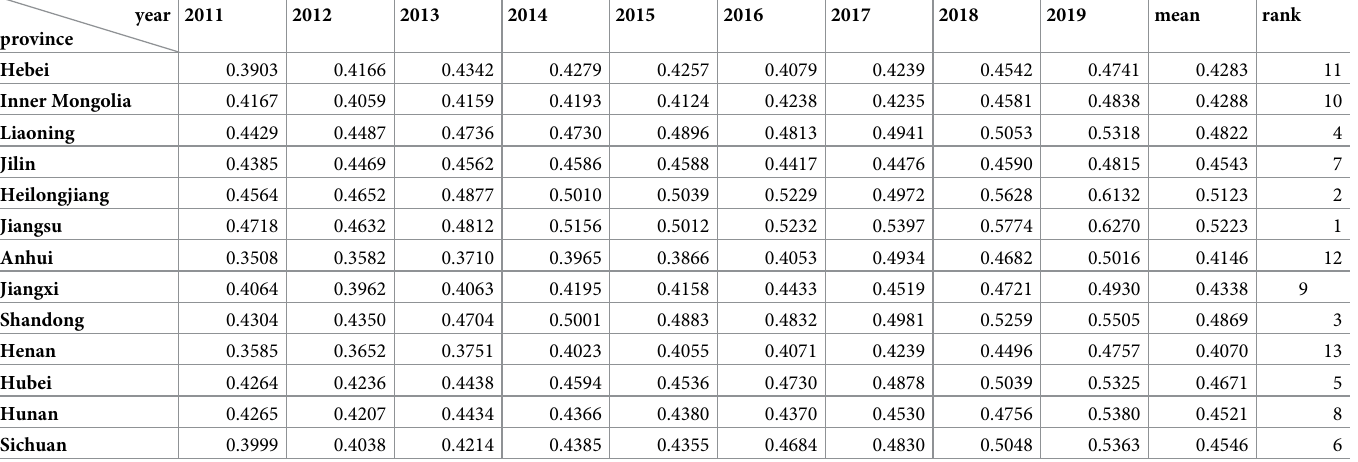
Table 4. Agricultural Green Development Index of 13 provinces in China’s main grain producing areas from 2011 to 2019. year